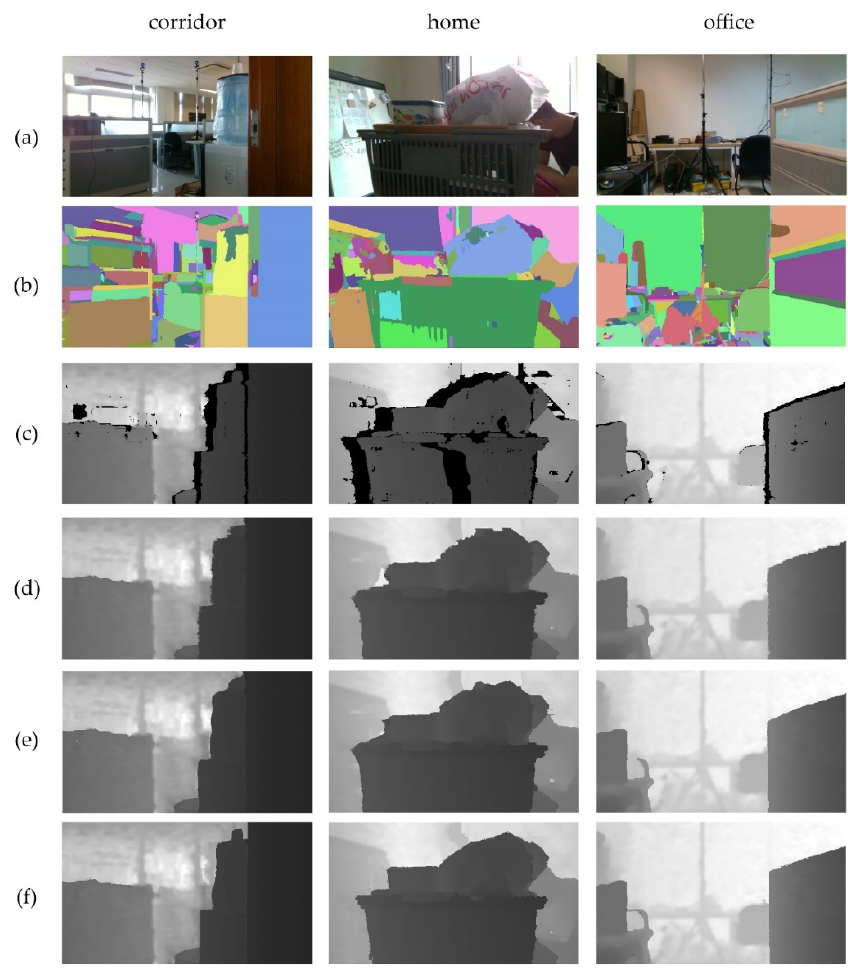
Figure 5. Region filling results of the other scenes: ( a ) RGB image; ( b ) segmentation of the RGB image; ( c ) raw depth image; ( d ) Criminisi method; ( e ) ASB–LS method; ( f ) proposed method.